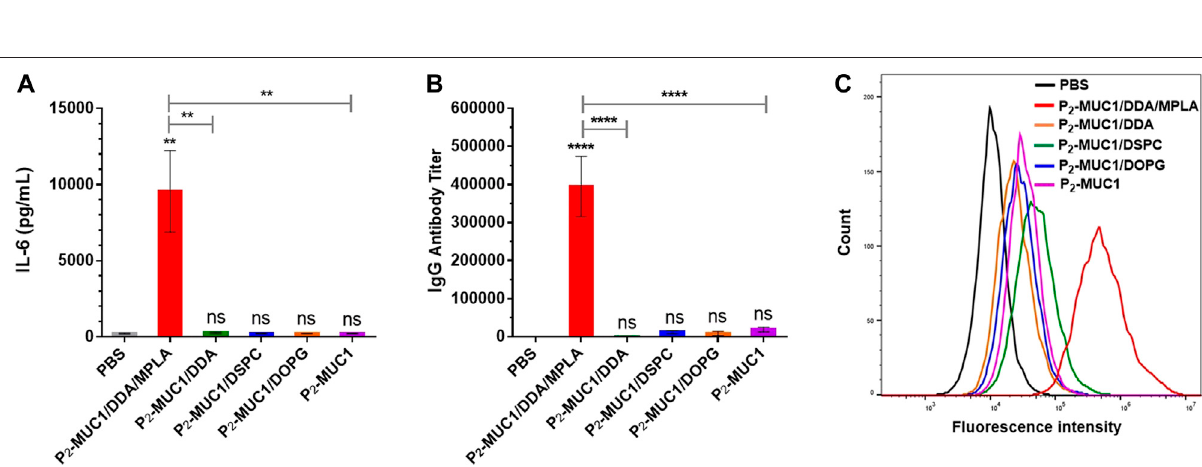
mole ratio of DDA and MPLA at 8:1, the cationic DDA makes its corresponding liposome positively charged.